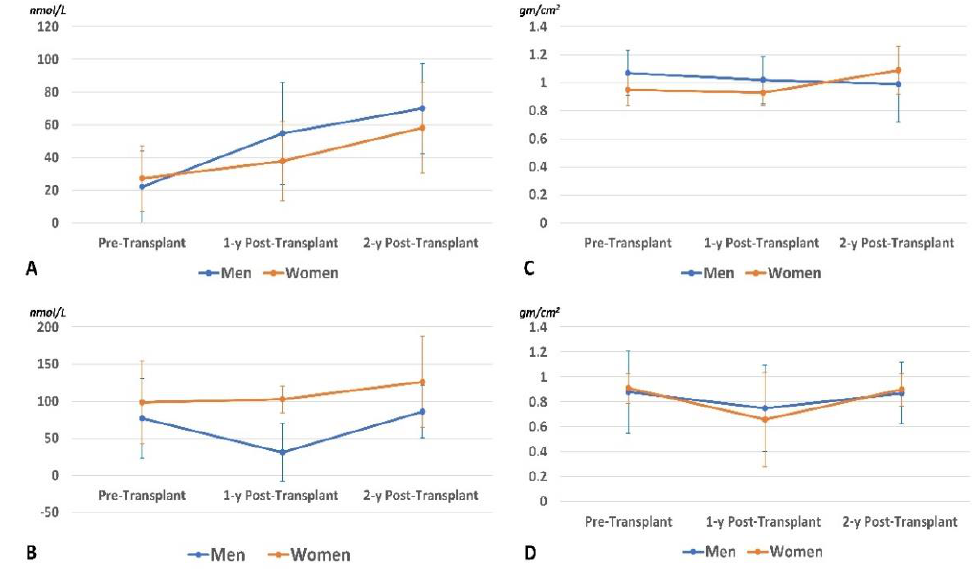
Figure 6. Longitudinal changes in the 25OHVD level ( A ), PTH level ( B ), BMD at the lumbar spine ( C ), and femoral neck ( D ).